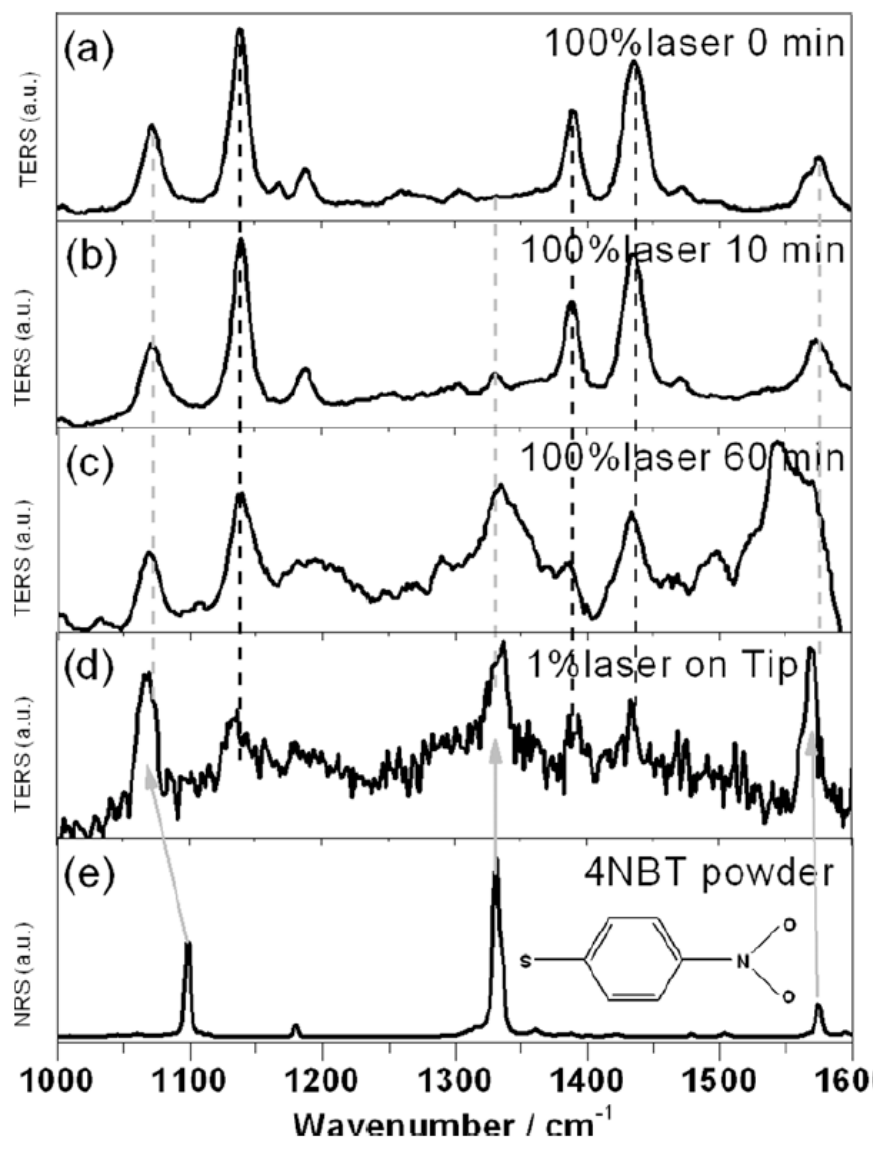
Figure 10. Experimental TER (alkaline conditions) and NR spectra. TER spectra of DMAB at ( a ) 0, ( b ) 10, and ( c ) 60 min. ( d ) TER spectrum on tip with weak excitation after strong excitation for 60 min. ( e ) NRS of 4NBT powder. Adapted from [11].